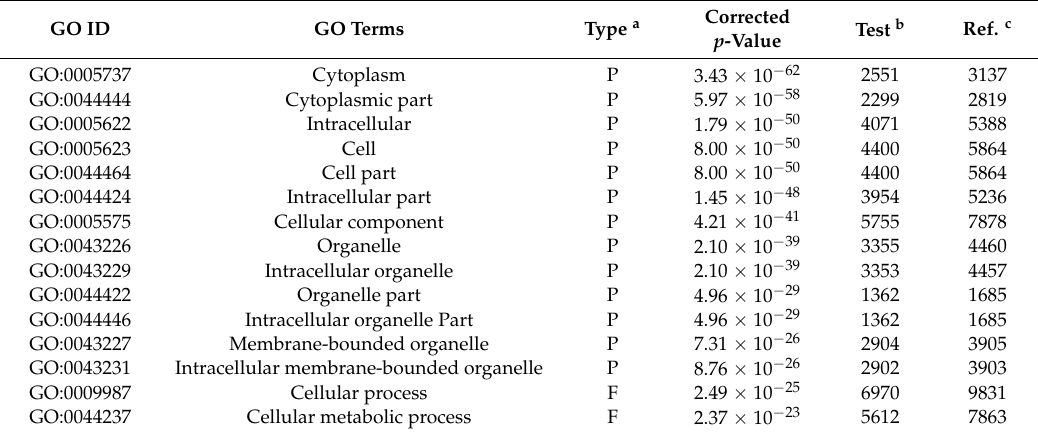
a GO ontology type: “F” represents ‘biological process“, and ”P“ represents ”molecular function“. b Number of mRNAs related to differentially expressed lncRNAs between potato dormant tubers and sprouting tubers. c Total number of transcripts belonging to each GO